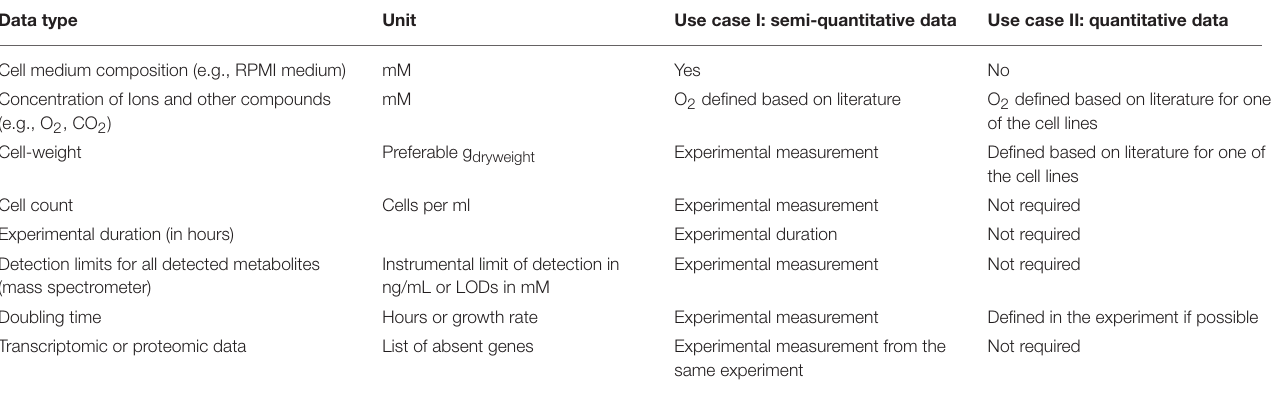
TABLE 1 | Additional data used for the intra-model analysis of metabolomic